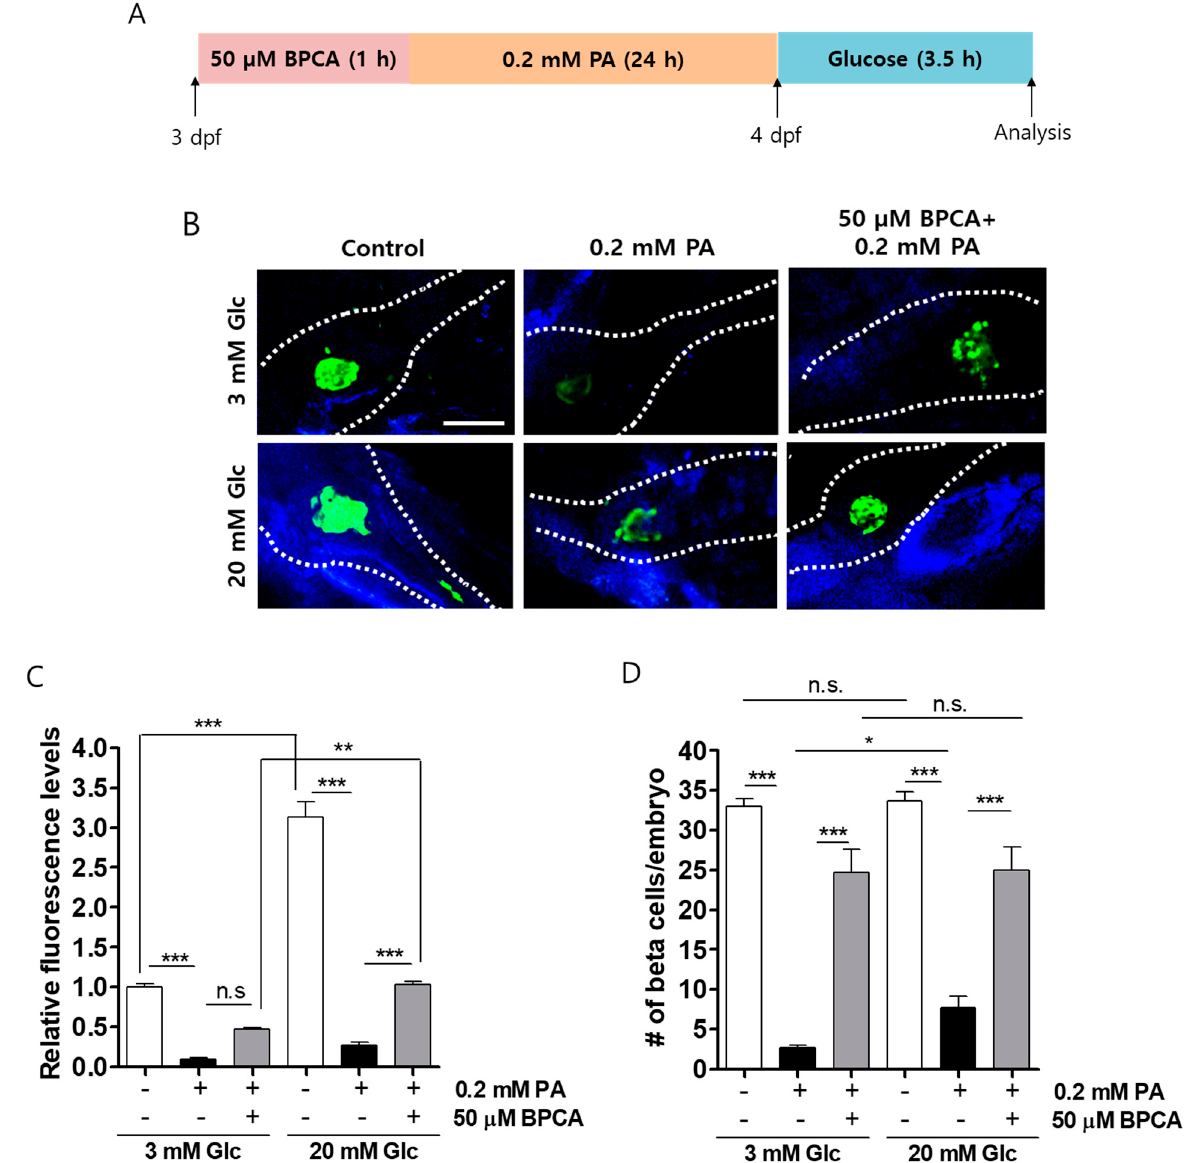
Figure 5. 5-Bromoprotocatechualdehyde (BPCA) isolated from Polysiphonia japonica protects against PA-induced β -cell dysfunction in zebrafish. ( A ) Zebrafish were incubated with 50 µ M BPCA and 0.2 mM PA from 3 to 4 days post-fertilization (dpf). BPCA was added 1 h prior to PA treatment. Thereafter, the zebrafish were incubated with 3 or 20 mM glucose for 3.5 h. ( B ) Confocal microscopy images of the pancreata of the zebrafish. Scale bar: 100 µ m. ( C ). Relative EGFP fluorescence levels from ( B ). ( D ) Numbers of β -cells per embryo from ( B ). n = 4~6. * p < 0.05, ** p < 0.005, *** p < 0.001, n.s. = no significance.